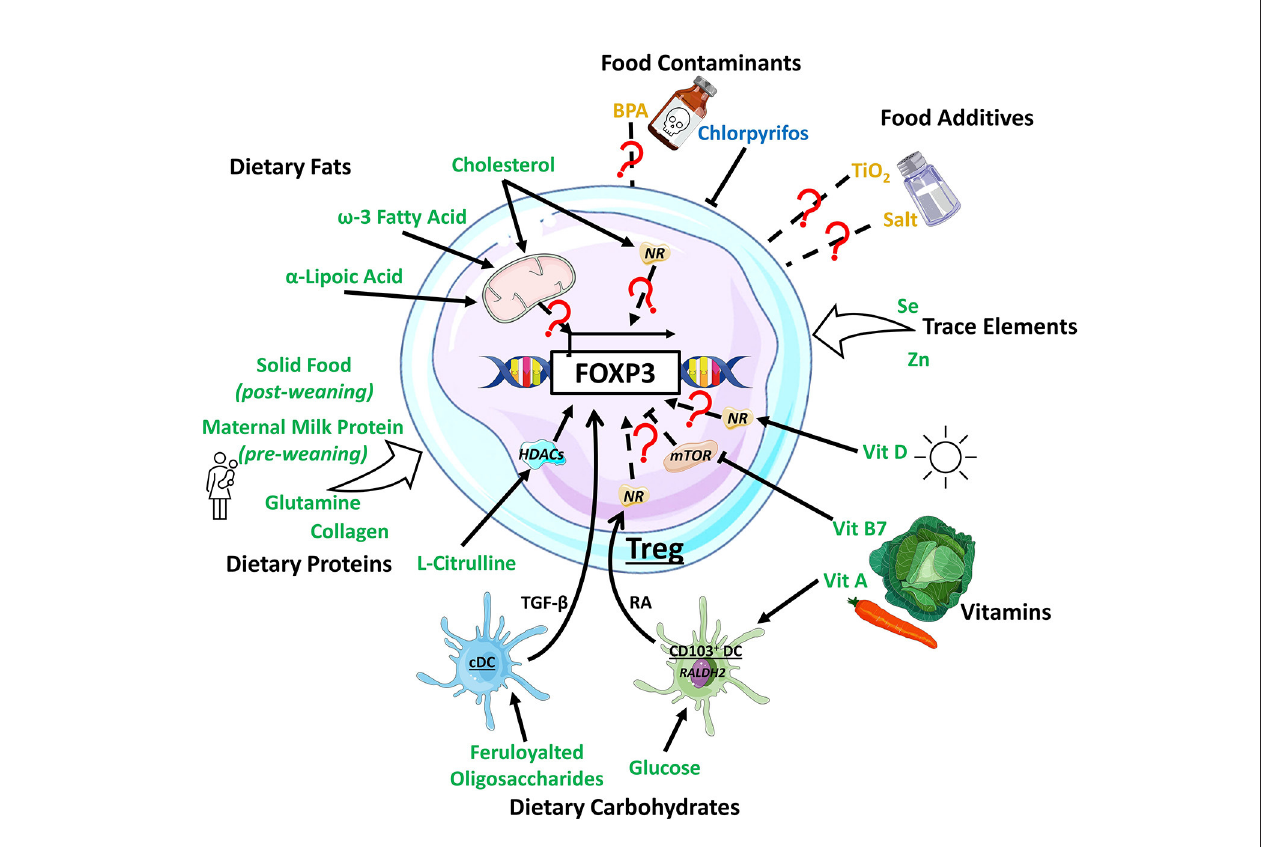
FIGURE 1 | Impact of dietary components on Treg development. Dietary components have varying effect on Treg development, with dietary fats inducing Treg by modulating metabolic activity or through the activation of nuclear receptors (NRs) such as PPAR δ . Dietary protein generally support Treg development, with L-citrulline enhancing the histone deacetylase (HDAC) Sirt1 to promote Treg development. Dietary carbohydrates, including feruloylated oligosaccharides and glucose act on conventional dendritic cell (cDC) and CD103 + DC, boosting their production TGF- β and retinoic acid (RA), respectively, to promote Treg. Vitamin (Vit) A is a substrate for RA production required for Treg induction while vitamin B7 and D finetune mTOR-related metabolic signals or bind to NRs to support Treg induction. Dietary trace elements like selenium (Se) and zinc (Zn) are supportive toward Treg development with unknown mechanisms. The food additives TiO 2 and salt, and the contaminant biphenol A (BPA) exhibit mixed/complex regulatory patterns toward Treg development while pesticides like chlorpyrifos suppressed Treg development. Dietary components promoting Treg development are colored in green, the ones impeding in blue, and the ones with mixed effect in